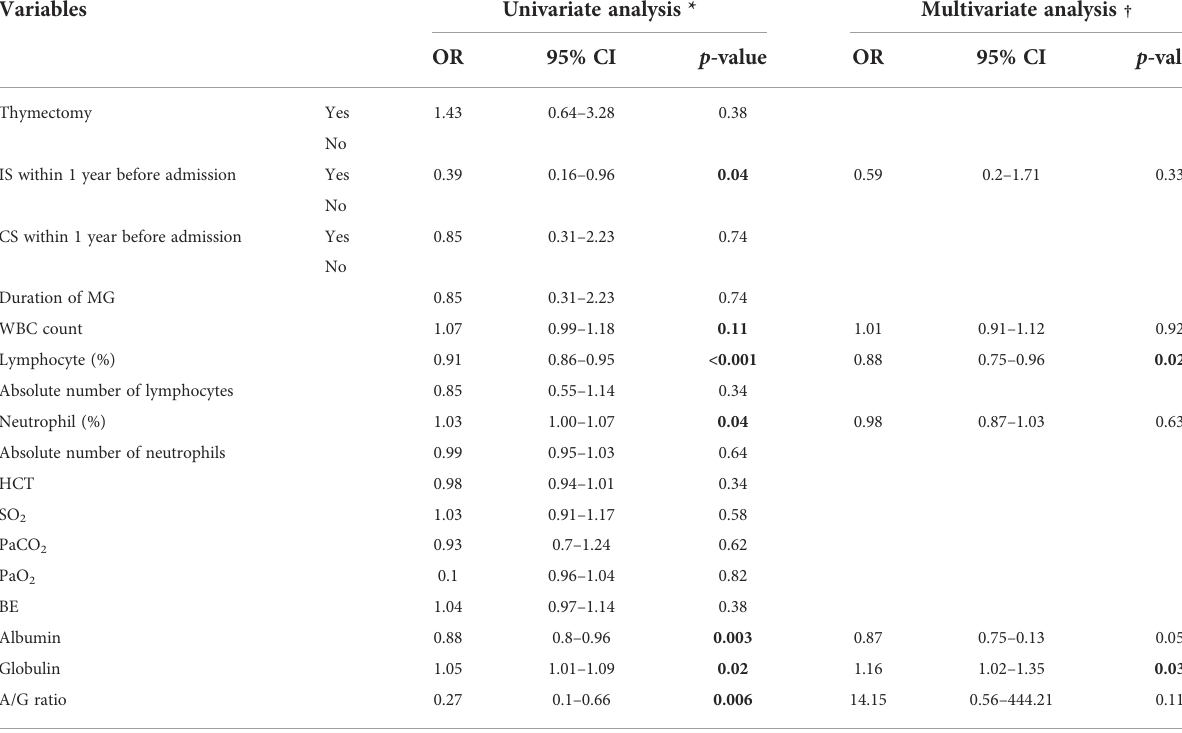
TABLE 2 Univariate and multivariate logistic regression models for the severe course in the hospitalized MG patients with pneumonia.